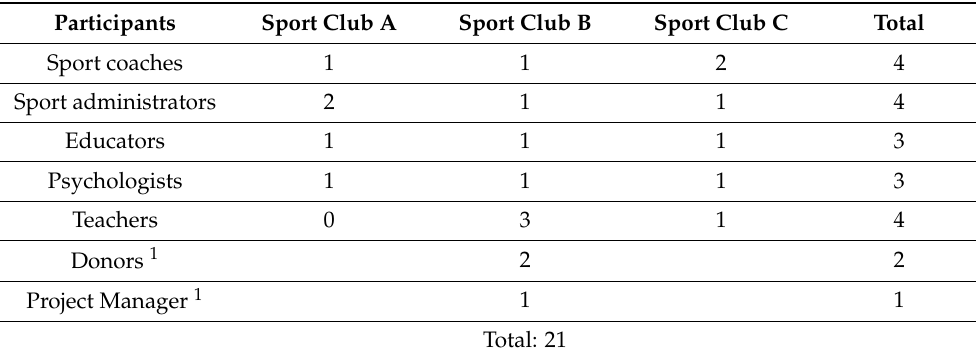
Table 2. Sample of the